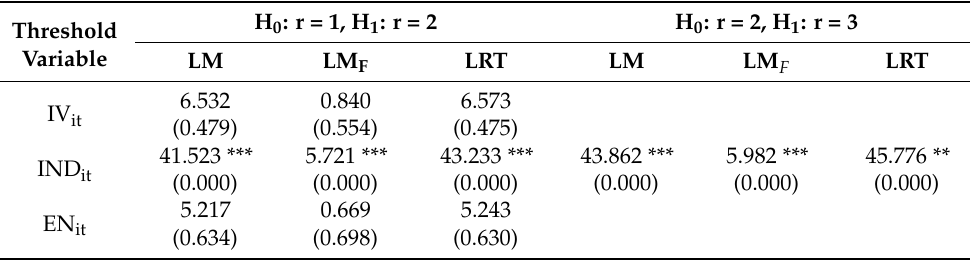
Table 5. Residual nonlinear test.